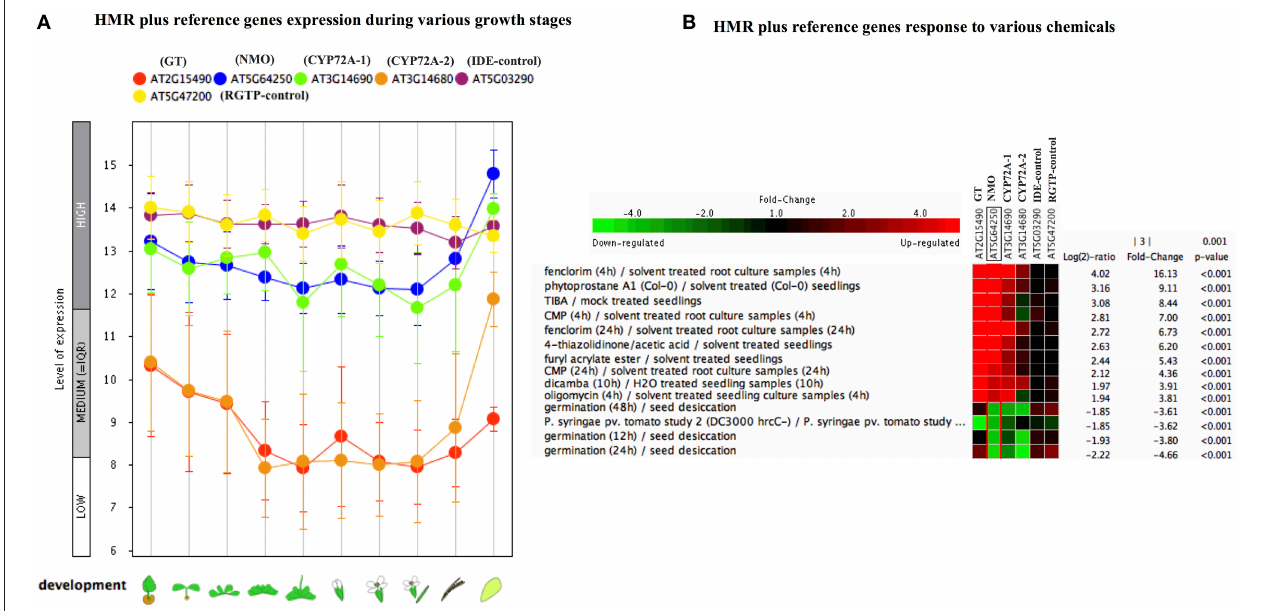
FIGURE 1 | Gene expression pattern of Lolium multiflorum orthologs of GT, NMO, CYPs along with control genes in A. thaliana . (A) Developmental stage-specific expression pattern. Left to right, “germinating seed,” “seedling,” “young rosette,” “developed rosette,” “bolting rosette,” “young flower,” “developed flower,” “flower and silique,” “mature silique,” and “senescence.” Our selected genes were tending to show higher expression in senescence. “HIGH,” “MEDIUM,” and “LOW” expression were based on microarray gene expression data found in GENEVESTIGATOR (http://www.genevestigator.com). (B) Heat map of expression of selected genes in response to various external conditions such as chemicals were analyzed using Genevestigator perturbation tool. Relative expression of the genes was represented in log 2 ratio and significant change in expression were filtered out based on NMO, p < 0.001 and fold change > 3. Expression of HMR genes strongly induced in response to various chemicals including herbicides and herbicide